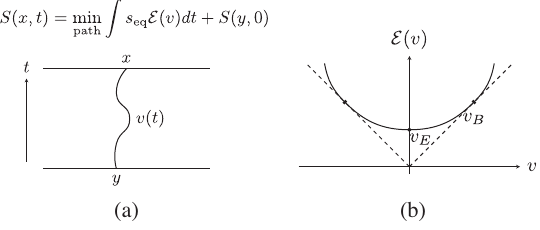
FIG. 1. The membrane picture of entanglement and other dynamical quantities. (a) Example of a membrane for evaluating R´enyi entropy growth in a 1D quench. Minimizing the membrane tension gives the entanglement. The tension is a function of local velocity v ¼ _ x . (b) Schematic line tension function for a chaotic system with parity symmetry. E ð v Þ is convex and tangential to j v j ; v at ð(cid:3) v B B Þ